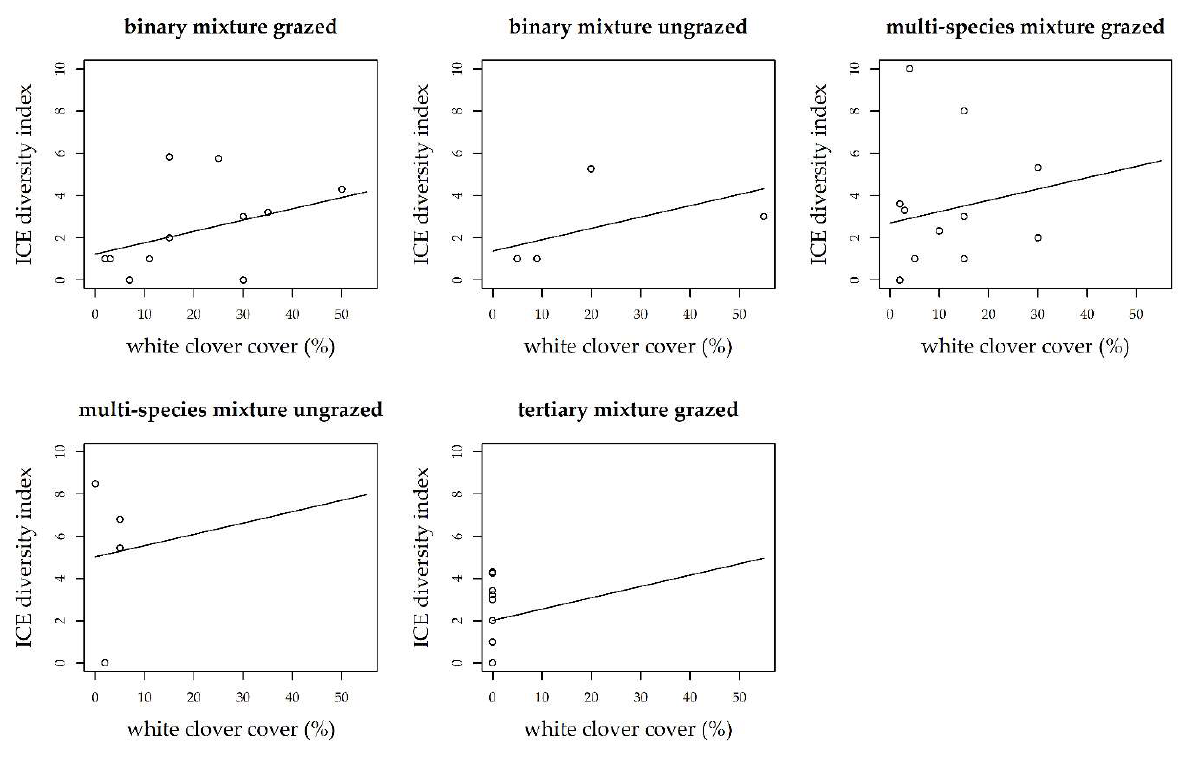
Figure 2. Effect of white clover flower cover on ICE diversity index of wild bees on the different mixtures and managements.